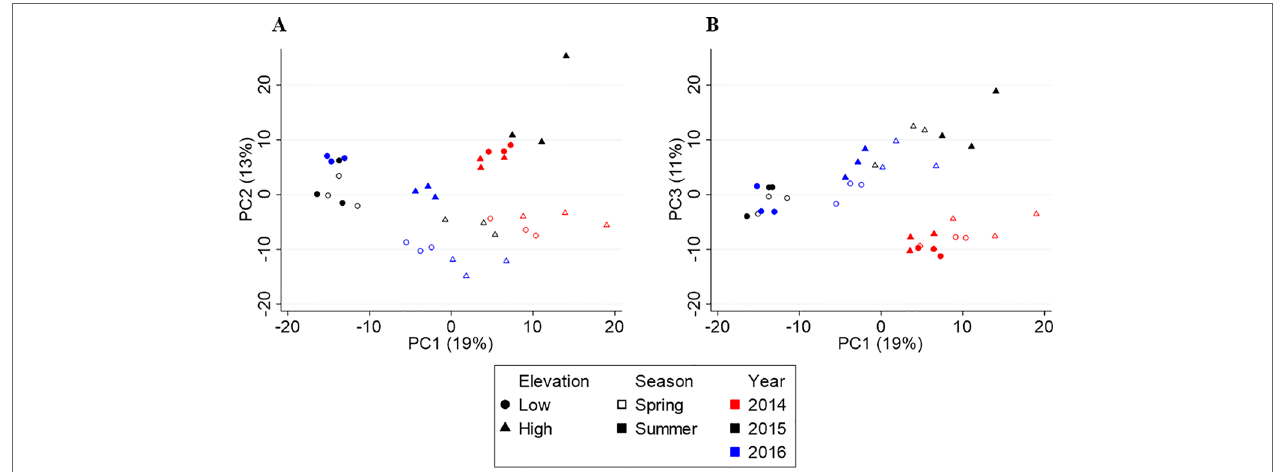
FIgURE 3 | Principal component analysis (PCA) score plots of Yunnan tea. (a) PC1 vs. PC2. (B) PC1 vs. PC3.